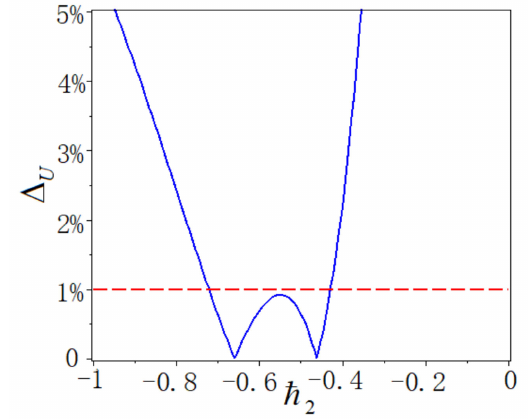
Figure 7. Relative errors curve ∆ U − h 2 of Equation (2.3c) when α = 2.0, ε 2 = 8/ π 2